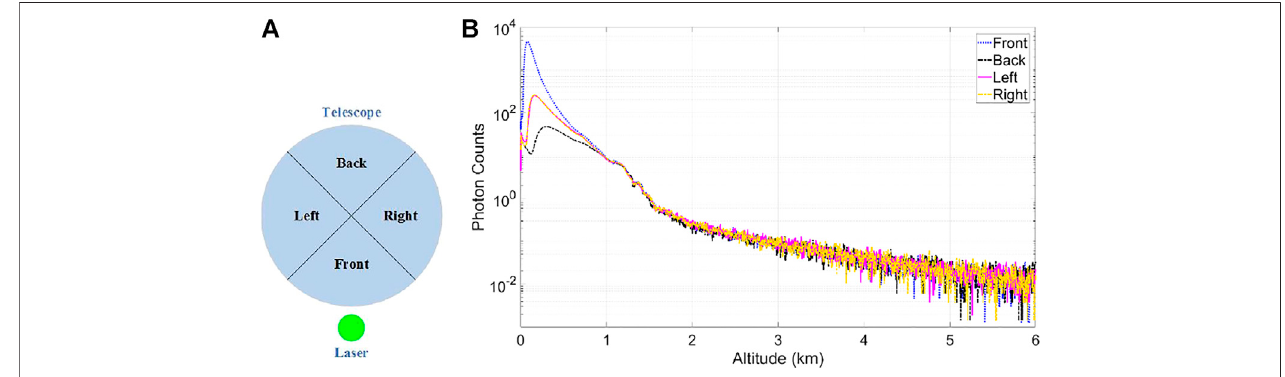
FIGURE 5 | (A) Four-quadrant division of the telescope. (B) Comparison of four-quadrant signals after collimation of the transmitting and receiving optical axes.